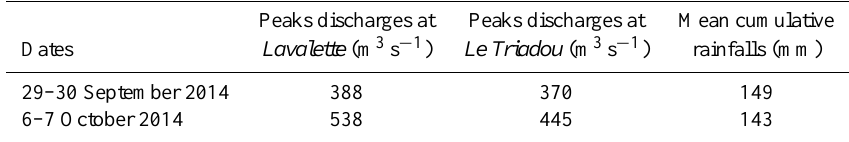
Table 1. Dates, peak discharges at Le Triadou and Lavalette gauging stations and mean cumulative rainfalls.